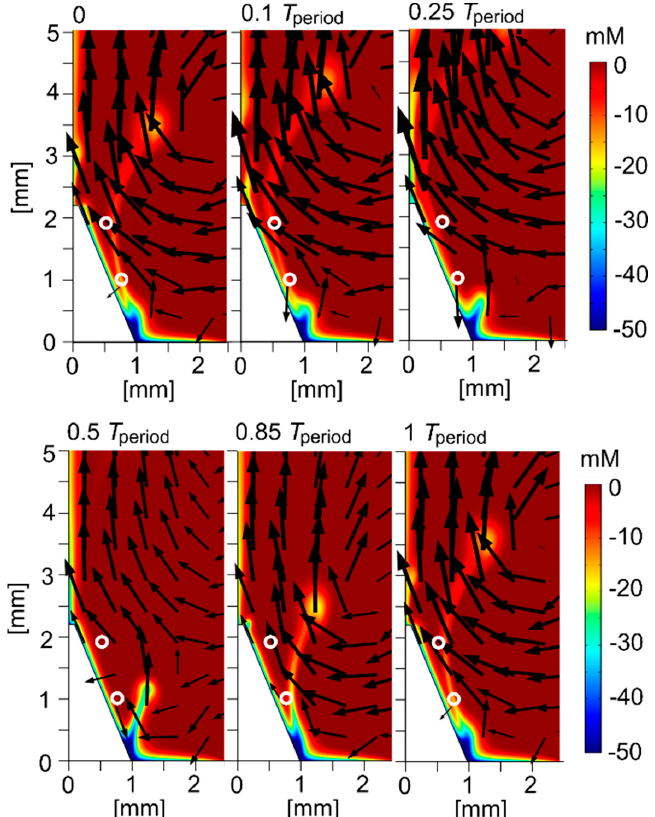
Figure 9. Numerical results of variation in concentration with respect to the bulk concentration on the vertical plane across the center of the cone for the instants marked with black circles in Figure 8, corresponding to 0, 0.1 T period , 0.25 T period , 0.5 T period , 0.85 T period , 1 T period during one oscillation period. The bulk concentration of CuSO 4 is 300 mM, J = 8 mA/cm 2 . The black arrows represent vectors of the meridional velocity of the electrolyte (logarithmic scale for better visibility). The white circles represent the monitoring points in Figure 8.